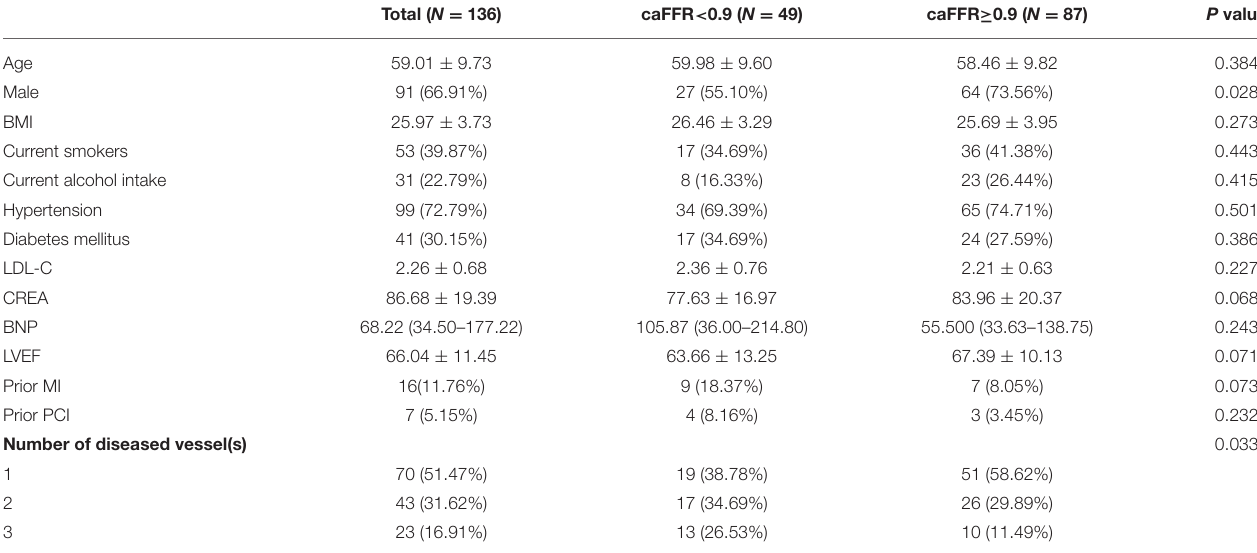
Values are n (%), mean ± SD or median (IQR). SD, standard deviation; IQR, interquartile range; caFFR, coronary angiography-derived fractional flow reserve; BMI, body mass index; LDL-C, low-density lipoprotein cholesterol; CREA, creatinine; BNP, type B natriuretic peptide; LVEF, left ventricular ejection fraction; MI, myocardial infarction; PCI, percutaneous coronary